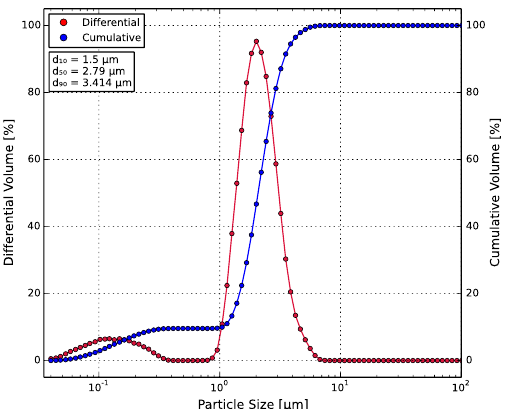
Figure 6. Particle size distribution of the BT particles, with red the differential and blue the cumulative volume. The particle distribution is bimodal, with the d 50 value lying at 2.79 µ m.